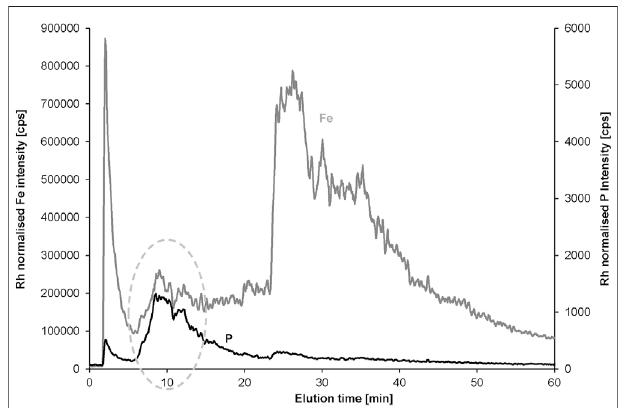
FIGURE5| AF4separationoftheDNA-spikedwatersampleHbh1using 50 kDa PVDF membrane and 10 min longer constant cross fl ow before the gradient (all other parameters were the same as for the data in Figure 4 ).